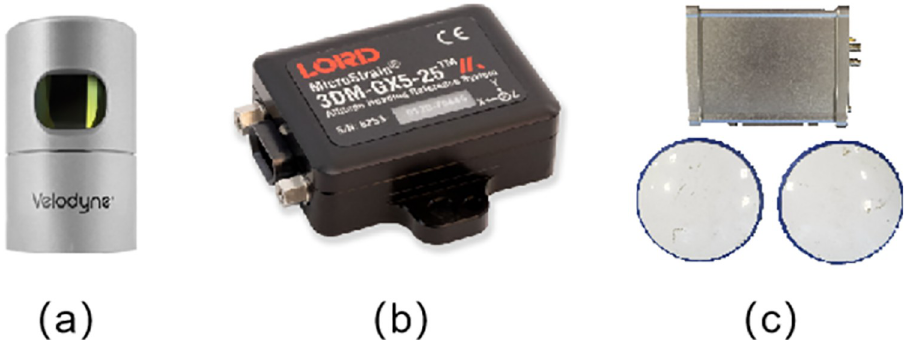
Fig 6. The sensor setup used in our experiments: (a) a Velodyne HDL-32E surround LiDAR sensor, (b) a 3DM-GX5 IMU, and (c) a Trimble BD982 GNSS receiver module with antennas.